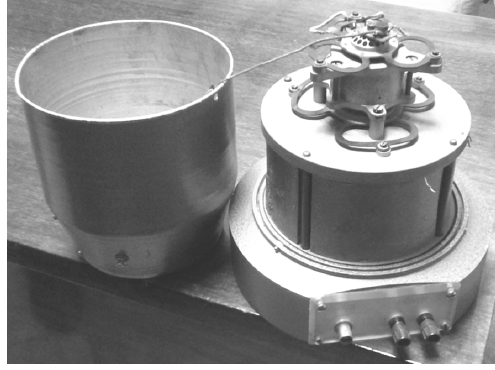
Figure 4. Mechanical vibration generator GMK-1.